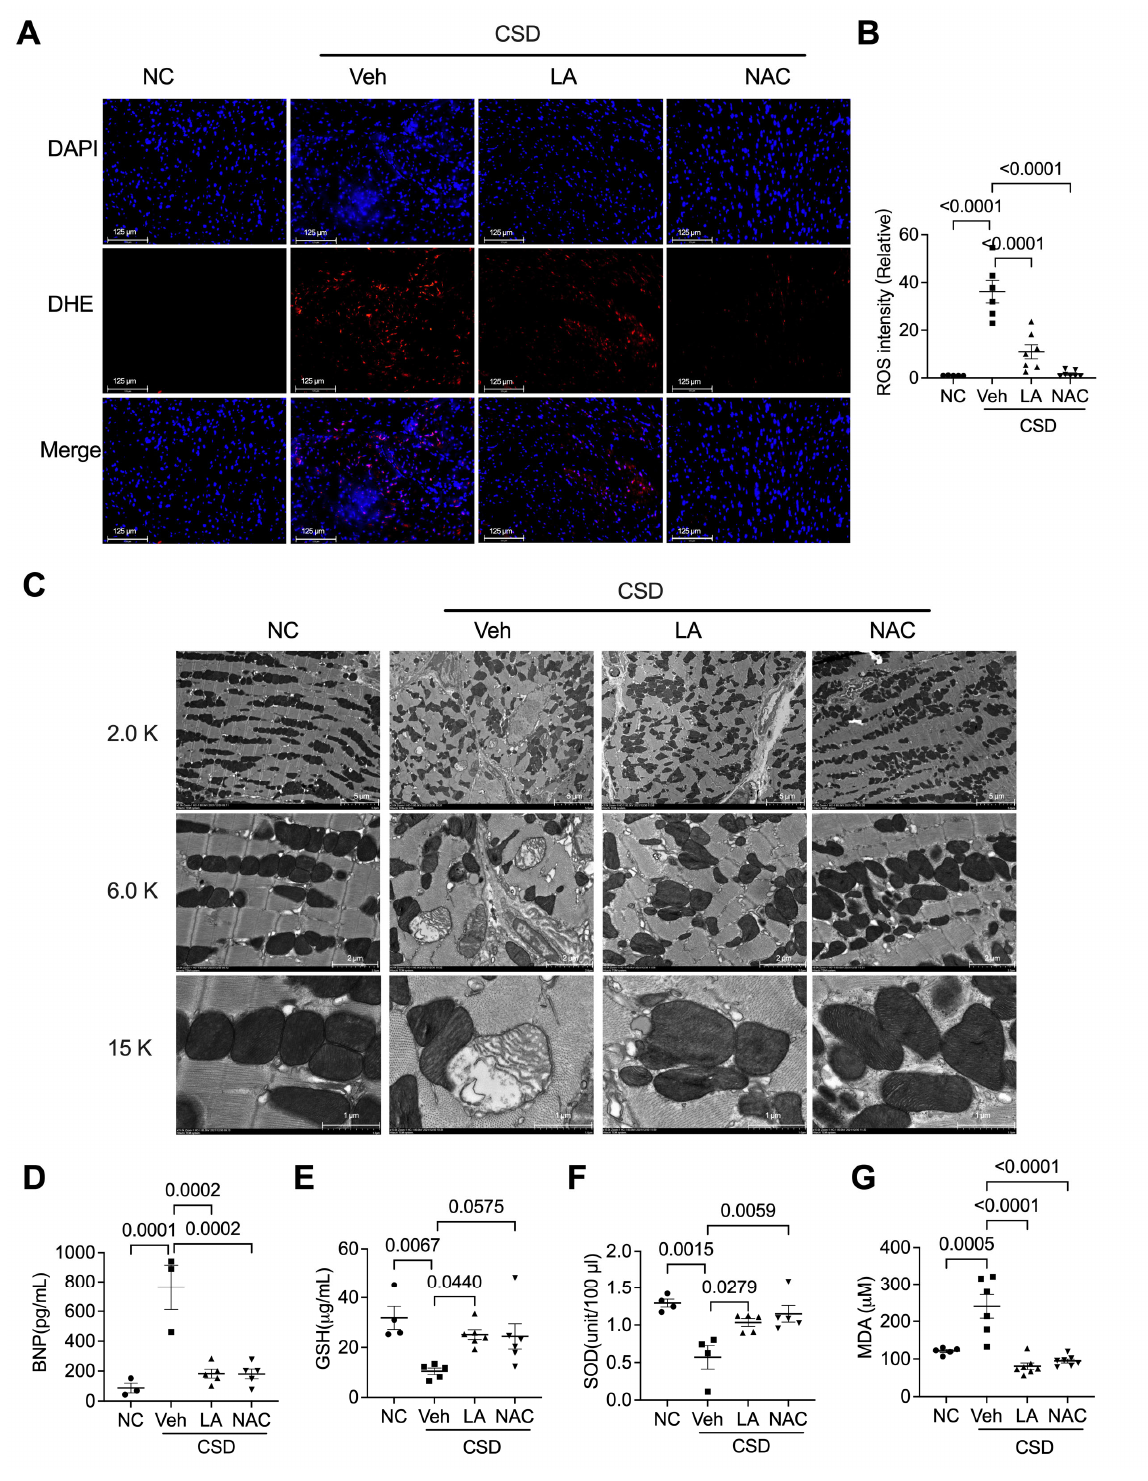
Figure 5. Antioxidants alleviated CSD-induced impaired mitochondria. ( A ) DHE staining images and analyzed data ( B ) unravel increased lipid peroxidation heart of four indicating groups (scale bar = 125 μ m). ( C ) Representative transmission electron microscopy (TEM) images of the heart of four indicated groups (scale bar = 5 μ m, 2 μ m, 1 μ m). Serum levels of BNP ( D ), GSH ( E ), SOD ( F ), and MDA ( G ) in four indicating groups.